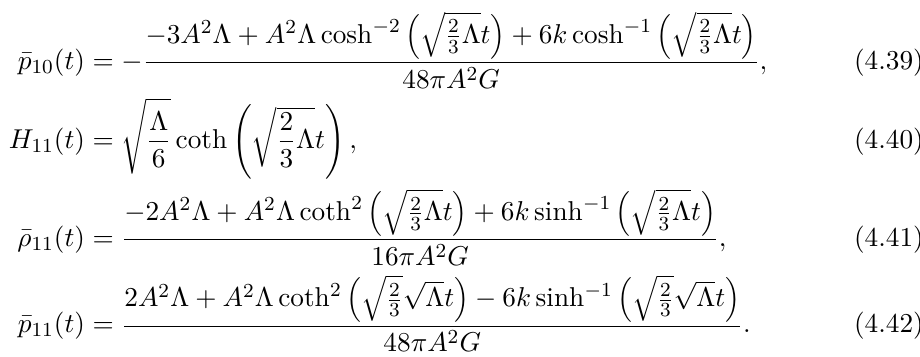
Figure 5 . Scale factors a 9 ( t ) = A e ± (cid:0)q (cid:1) , (green) are on the left side. The corresponding Hubble parameters 2Λ A sinh 1 2 t 3 and H ( t ) are on the right 11